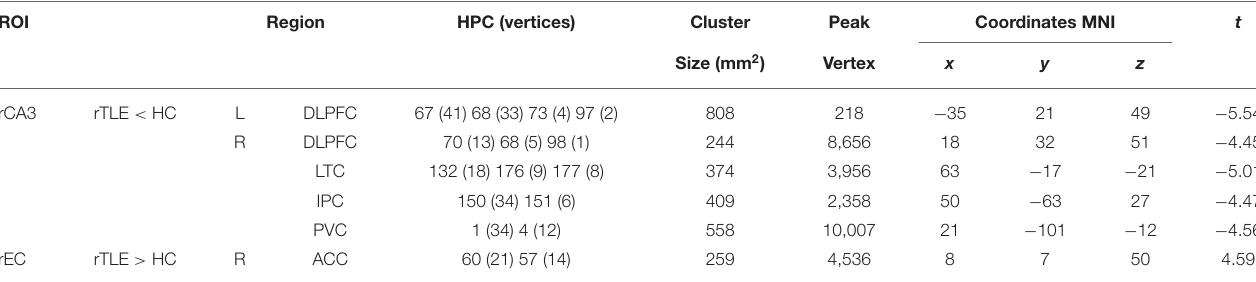
TABLE 3 | Intergroup differences of vertex-wise SBFC of the right posterior hippocampal subfields in rTLE vs. HCs.